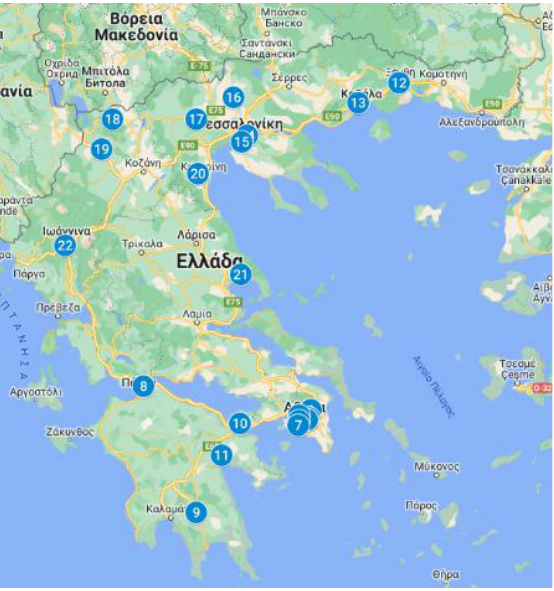
Figure 11. Map showing the location and identification number of the hospitals considered in the present study.